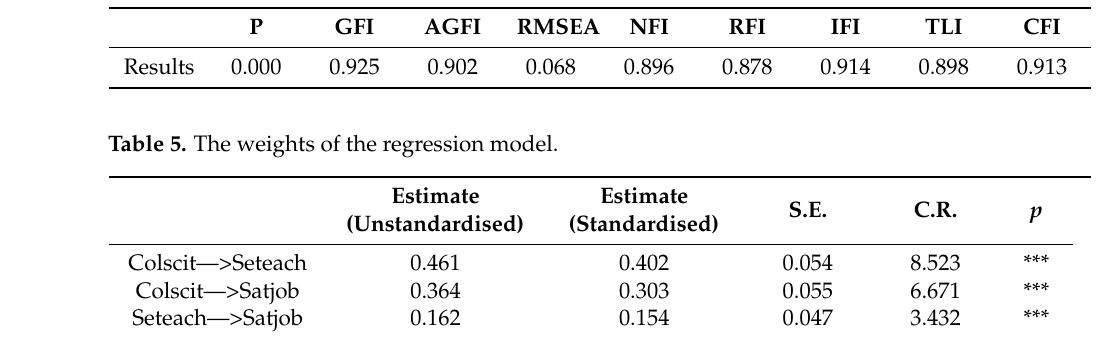
Table 4. Indicators of model fitness and their computational results.